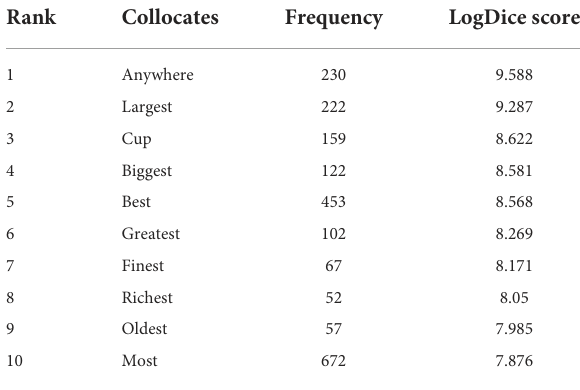
TABLE 5 The collocates of in the world within a four-word